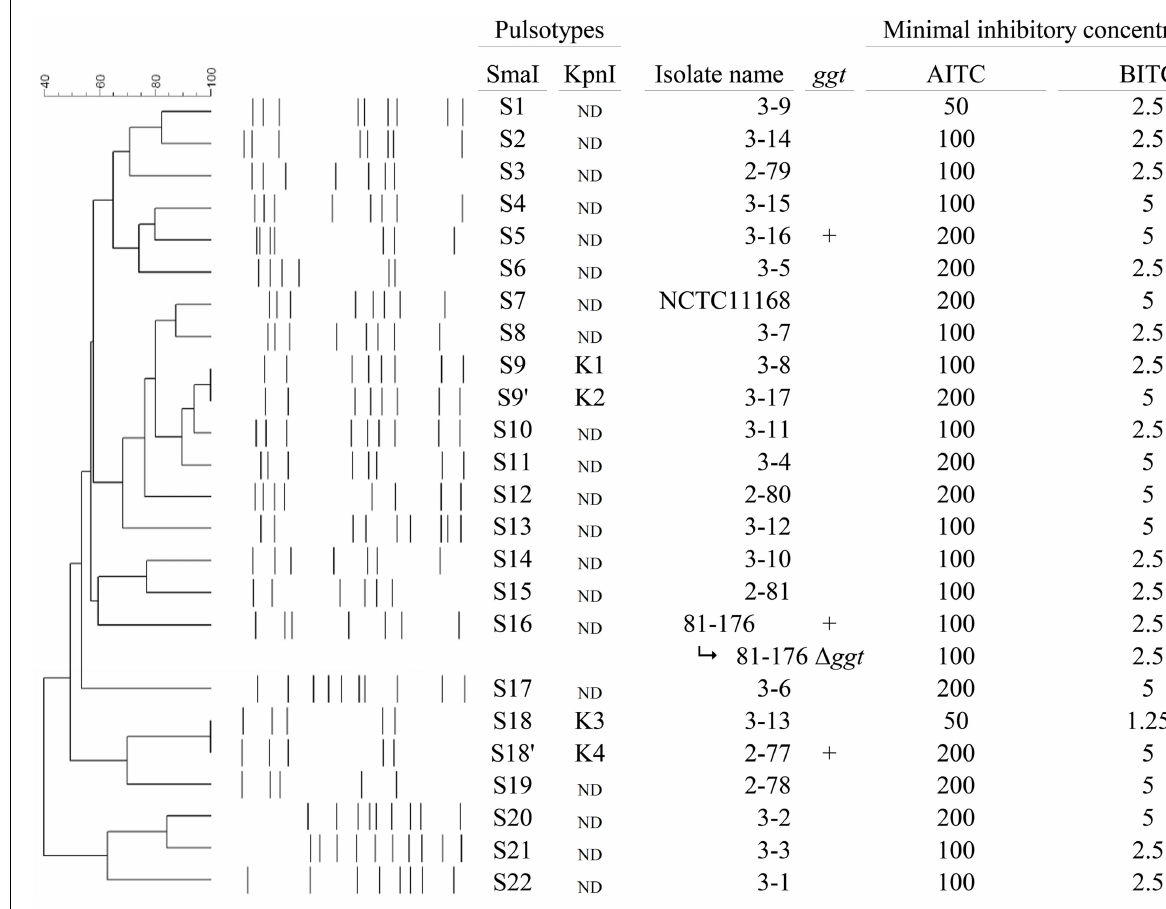
FIGURE 1 |AITC and BITC minimal inhibitory concentrations (determined by agar dilution method) on 24 C. jejuni isolates. From left to right: dendrogram generated using Dice’s coefficient and showing isolates grouping based on Sma I PFGE; Sma I PFGE profiles; Sma I and Kpn I pulsotypes of the